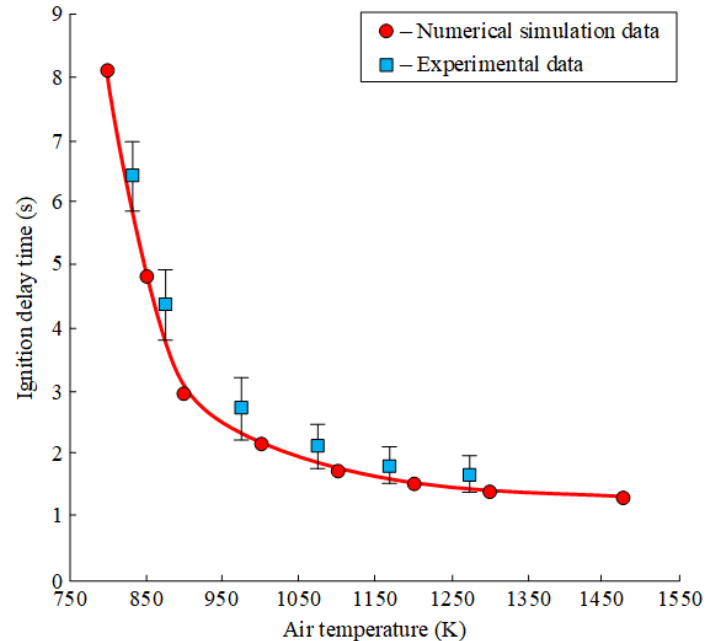
Figure 23. Dependence of the ignition delay time of gel fuel particles on the temperature of heated air at r p = 1.25 mm, µ 4 = 48%